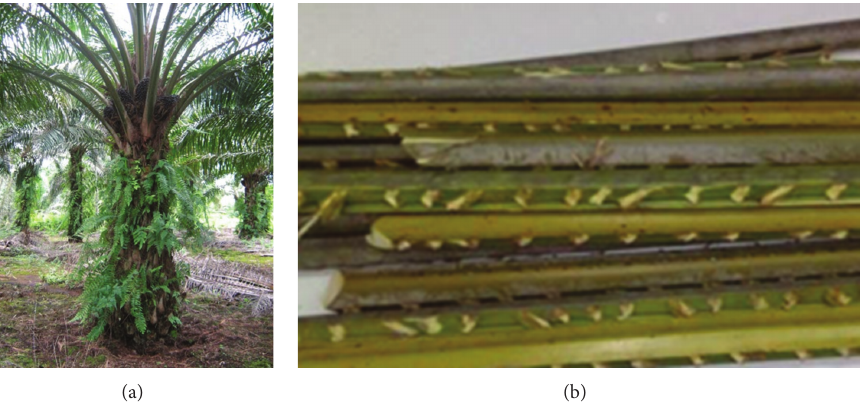
Figure 1: Oil palm biomass (a) picture of oil palm tree, (b) oil palm fronds.